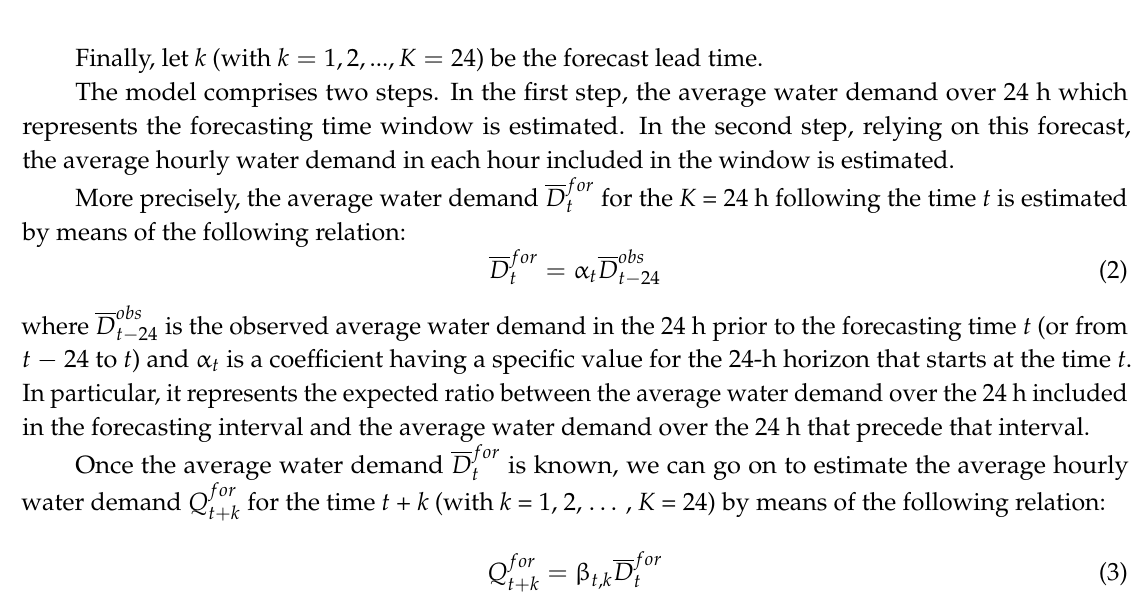
Figure 1. Time structure of the proposed model named αβ Water Demand Forecasting ( αβ _WDF).